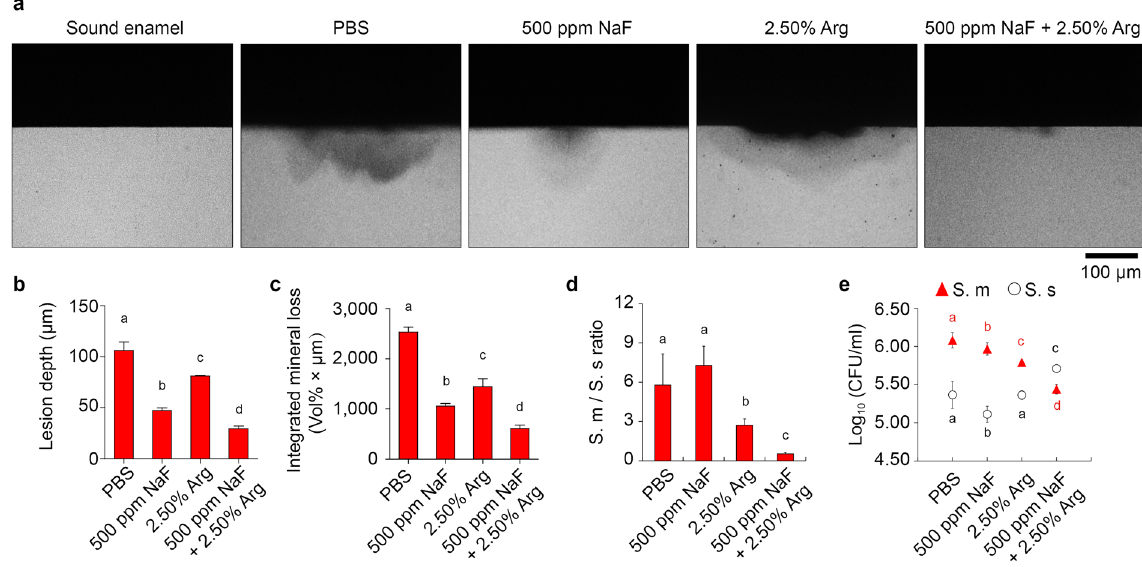
Figure 5. Combinatory use of fluoride augments the anti-demineralization effect of arginine against saliva- derived biofilm. ( a ) Representative Transverse Microradiography (TMR) images of human enamel discs exposed to 10-day biofilm-induced experimental demineralization. The high-density regions represent the sound enamel tissues, while the low-density shadows indicate the caries-like lesions. Lesion depth ( b ) and integrated mineral loss ( c ) were calculated. Data are presented as mean ± s.d. (n = 3; one-way ANOVA test followed by Student-Newman-Keuls test; different letters indicate significant inter-group differences, p < 0.05). Quantitative data of S. mutans (S. m)/ S. sanguinis (S. s) ratio ( d ) and number ( e ) in the 24-hour human saliva- derived multispecies biofilm. Bacterial numbers were determined by qPCR. Data are presented as mean ± s.d. [n = 6; one-way ANOVA test followed by Student-Newman-Keuls test; different red letters (S. m number) and black letters (S. m/S. s ratio and S. s number) indicate significant inter-group differences, p < 0.05]. Arg = arginine; CFU = colony-forming